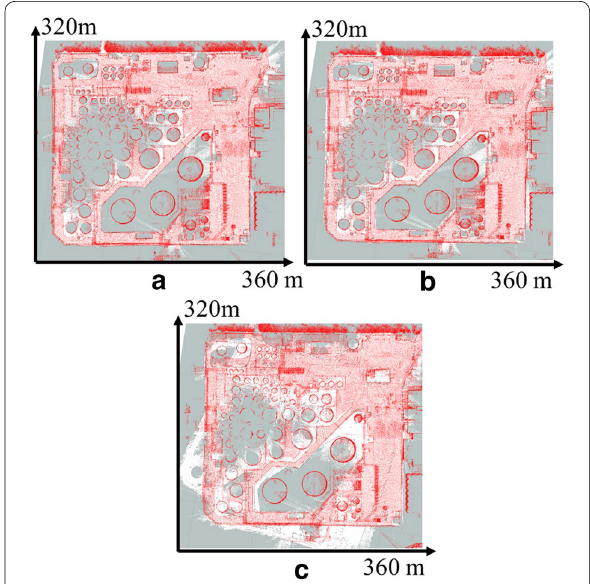
Fig. 19 Data in petrochemical complexes where red is ground truth MMS data and the result of SLAM: a FS 2.0 based on GPS and LIDAR map and b FS 1.0 based on GPS and LIDAR map are visually shown to have consistency. On the other hand, c Karto SLAM based on LIDAR map has no consistency because large distortions are evident on the map